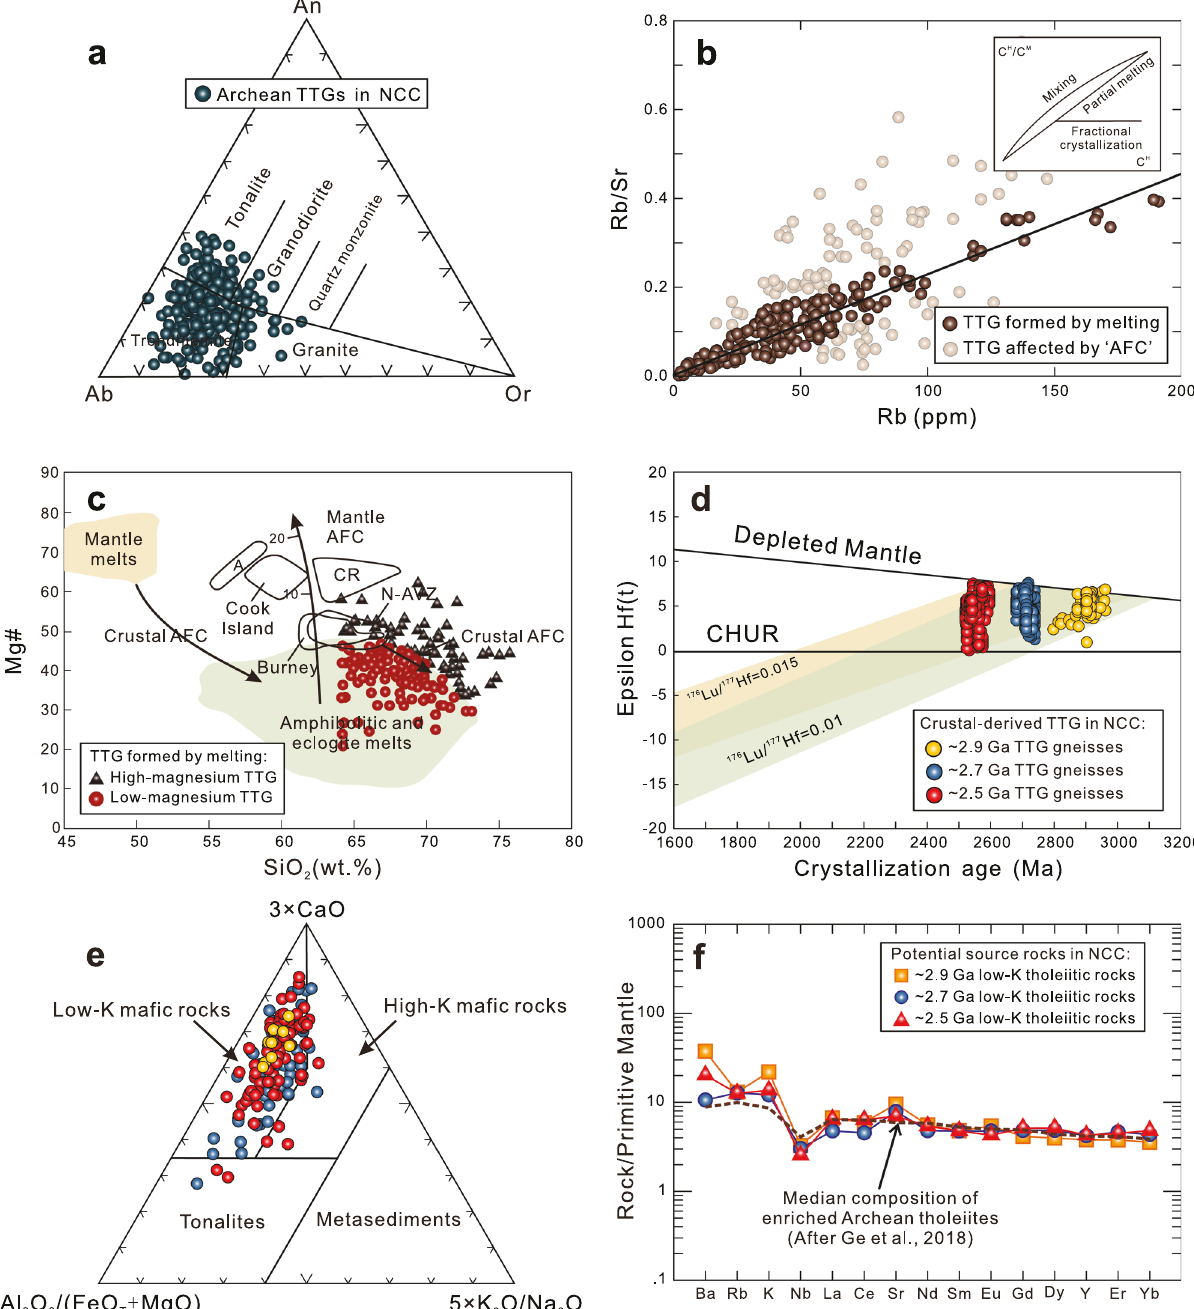
Fig. 2 Geochemical diagrams for the Meso- to Neoarchean TTG gneisses from the Eastern Block of the North China Craton. a An-Ab-Or diagram (after Barker 33 ); b Rb/Sr versus Rb (ppm) diagram, the inset is a schematic C H /C M versus C H plot, with C H and C M as concentrations of highly and moderately incompatible elements, respectively (after Schiano et al. 34 ); c Mg# versus SiO 2 (wt.%) diagram (modi fi ed after Stern and Killian 36 ). This also shows the fi eld for pure crustal partial melts obtained in experimental studies by dehydration melting of amphibolitic rocks and eclogites 29,35 ; d Plots of the zircon ɛ Hf(t) values versus crystallization ages (Ma) for the dated crustal-derived TTG samples (Supplementary Data 2); e Ternary diagram of Al MgO), 3 × CaO, and 5 × (K 2 O/Na 2 O). The fi elds represent the composition of melts derived from a range of potential sources of tonalites, metasediments, and low- and high-K ma fi c rocks 38 ; f Trace element patterns for the average composition of ~2.9 Ga, ~2.7 Ga and ~2.5 Ga low-K tholeiitic rocks from the Eastern Block of the North China Craton. The median values for the enriched Archean tholeiites are from Ge et al. 27